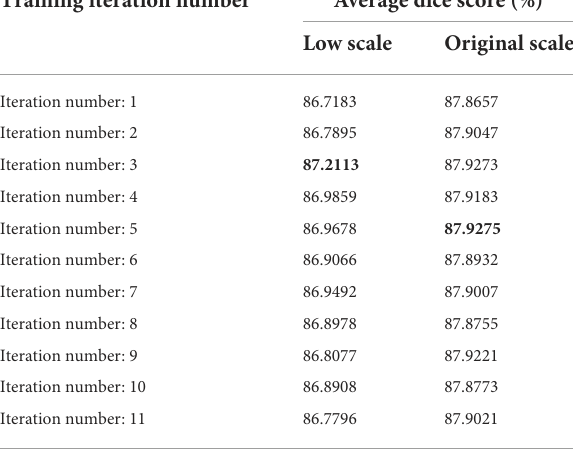
TABLE 6 Study on dynamic data augmentation at different scales. TABLE 7 The average dice scores (%) between the conventional recursive cascade method with information loss and our proposed method on the mouse brain test